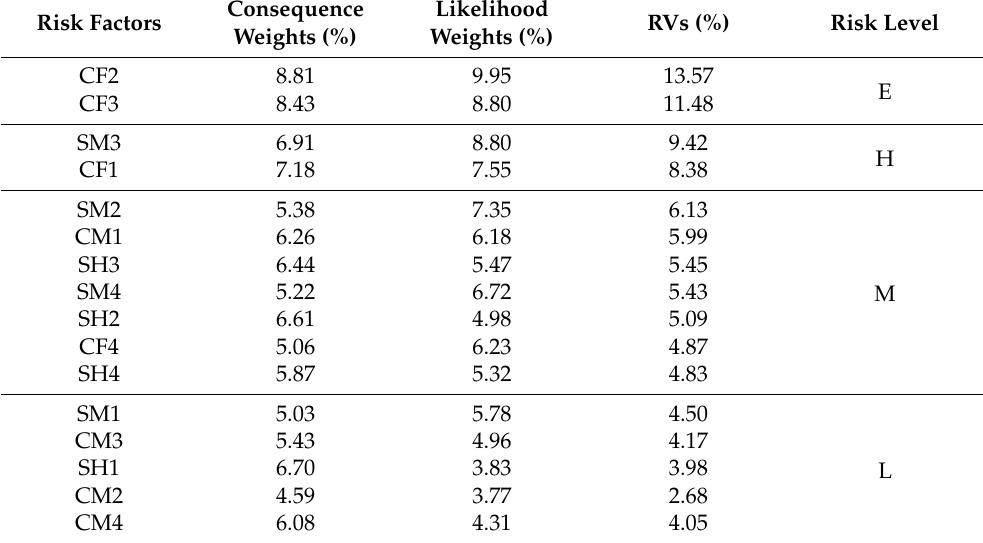
Table 8. The results of traditional risk matrix.